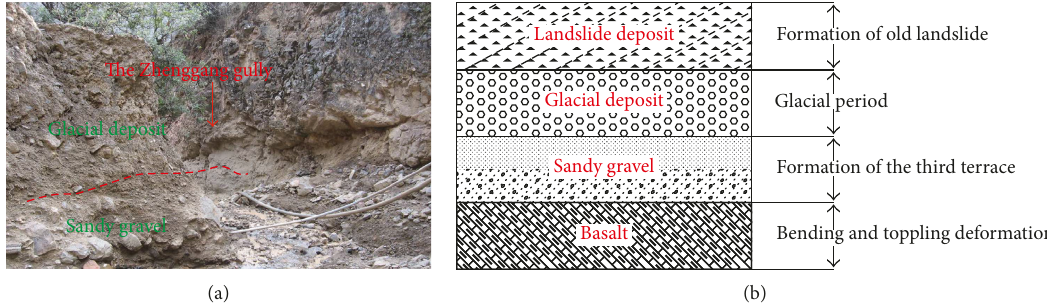
Figure 7: The stratigraphic contact relationship of the Zhenggang